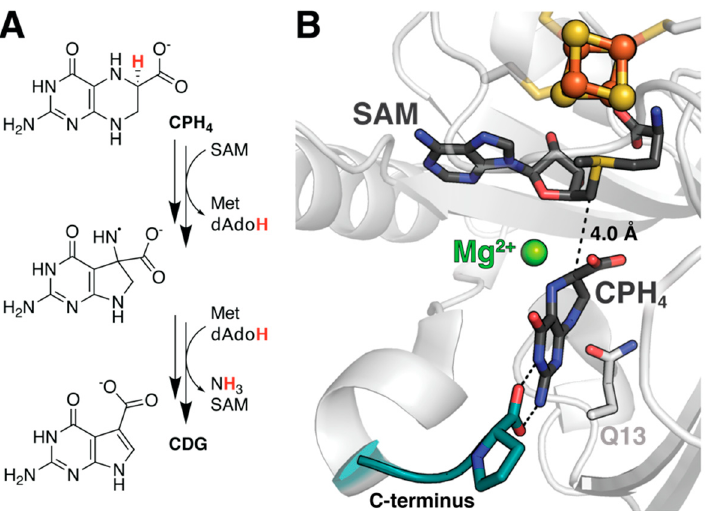
Figure 4. Subtle structural features of the QueE reactant complex are crucial for enzyme reactivity. ( A ) Reaction scheme for QueE. ( B ) A series of docking, MD, DFT, and QM/MM studies have demonstrated the importance of divalent ion identity and substrate deformation to both stabilize the reactant complex and facilitate catalysis. Decreased flexibility in the C ‐ terminal tail was also observed following reaction initiation in QueE (PDB accession codes: 4NJI).